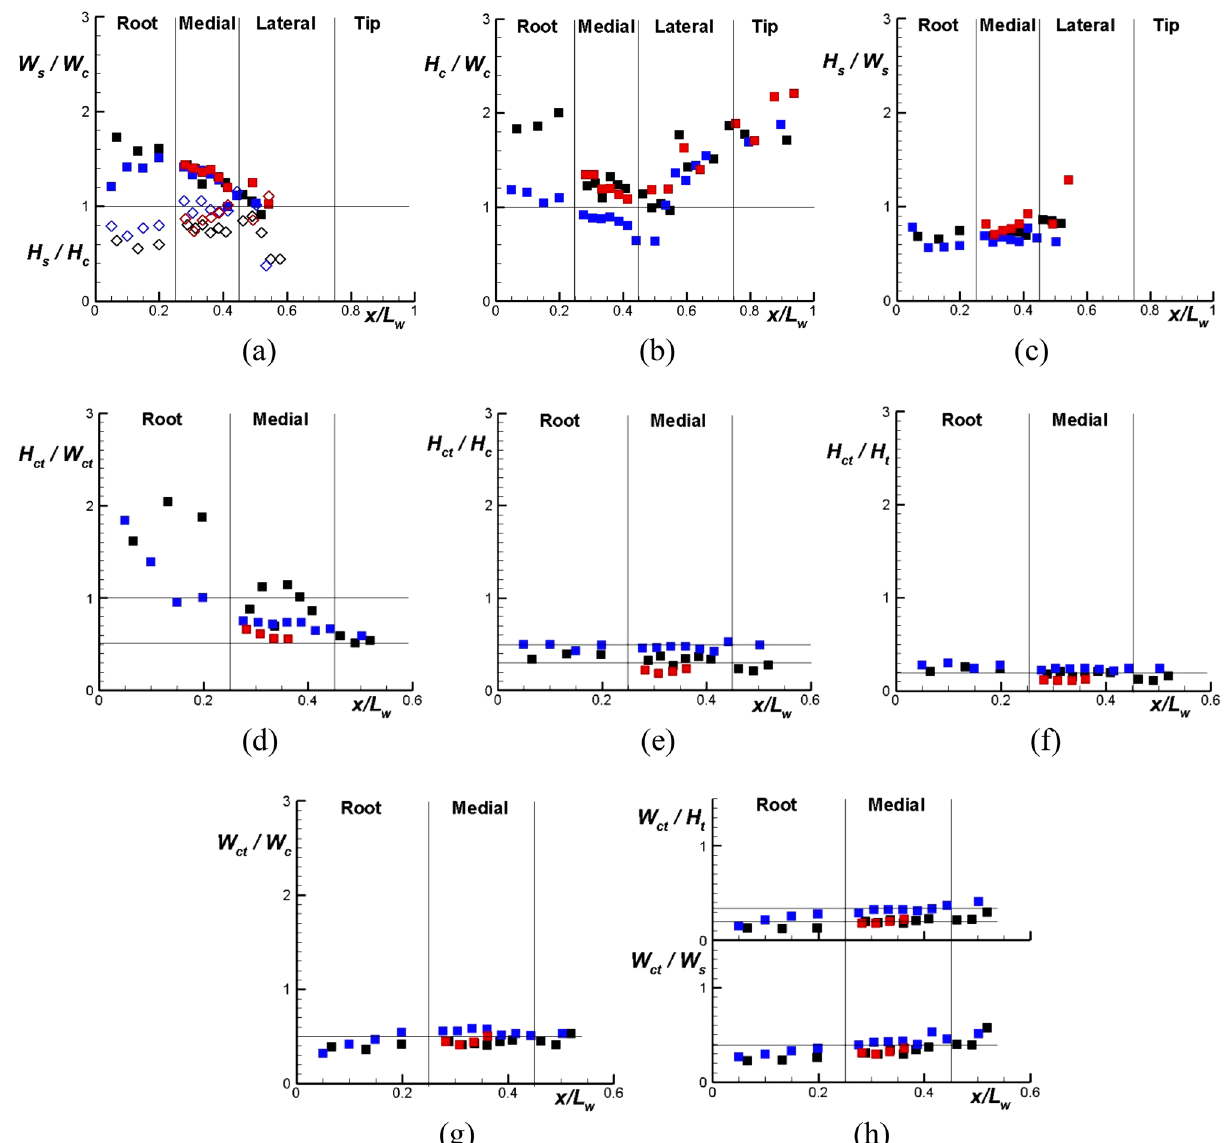
Figure 4. Ratios between the leading edge characteristic heights and widths along the wing in the direction from the wing root ( x / L w = 0 ) to its tip ( x / L w = 1 ).The boundaries of the wing Root, Medial, Lateral, and Tip sections as shown correspond to x / L w = 0.25, 0.45, and 0.75, approximate values for the three cicadas. Color scheme: black – Cicada 1, blue – Cicada 2, red – Cicada 3. Symbols in ( a ): open— H s / H c , closed— W s / W c The ratio of the tip height to its width, H ct / W ct , reduces in the direction from the insect body toward the costa and subcosta merging point (Fig. 4d), with the tip height twice as large as the tip width close to the insect body, but the tip width twice as large as the height in the merging point proximity. The ratio of the costa tip and costa heights, H ct / H c , varies little along the wing. There is a small reduction in its value in the wing Root part in the direction toward the costa and subcosta merging point, which is similar in the two wings (no such data are available for the third wing). In the Medial part, the ratio value can be approxi- mated as constant for the three cicadas in the range between 0.3 L w and 0.5 L w (Fig. 4e). Less scatter is observed when the costa tip height is normalized by the total leading edge height: H ct / H t , with the ratio average value of 0.2 L w in both the Root and Medial parts of the three wings (Fig. 4f). When considering data for the costa tip width, results for the ratio W ct / W c (Fig. 4g) are similar to those for the ratios W ct / W s and W ct / H t (Fig. 4h). That is, the costa tip width with respect to these parameters slightly increases through the wing Root section, but changes little in the wing Medial part. When W ct is normalized by the costa and subcosta widths, W ct / W c and W ct / W s , the values were found to be common for the three cicadas: 0.5 and 0.4, respectively. All widths and heights used in Fig. 4 are also shown in Supplementary Fig. S6 online normalized by the wing length to complement information above. When looking at the behavior of the costa tip width and height (open